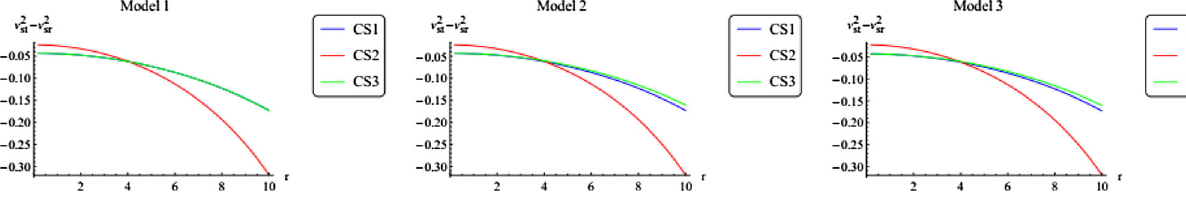
Fig. 12 Variations of v 2 st − v 2 sr for different viable f ( G ) gravity models